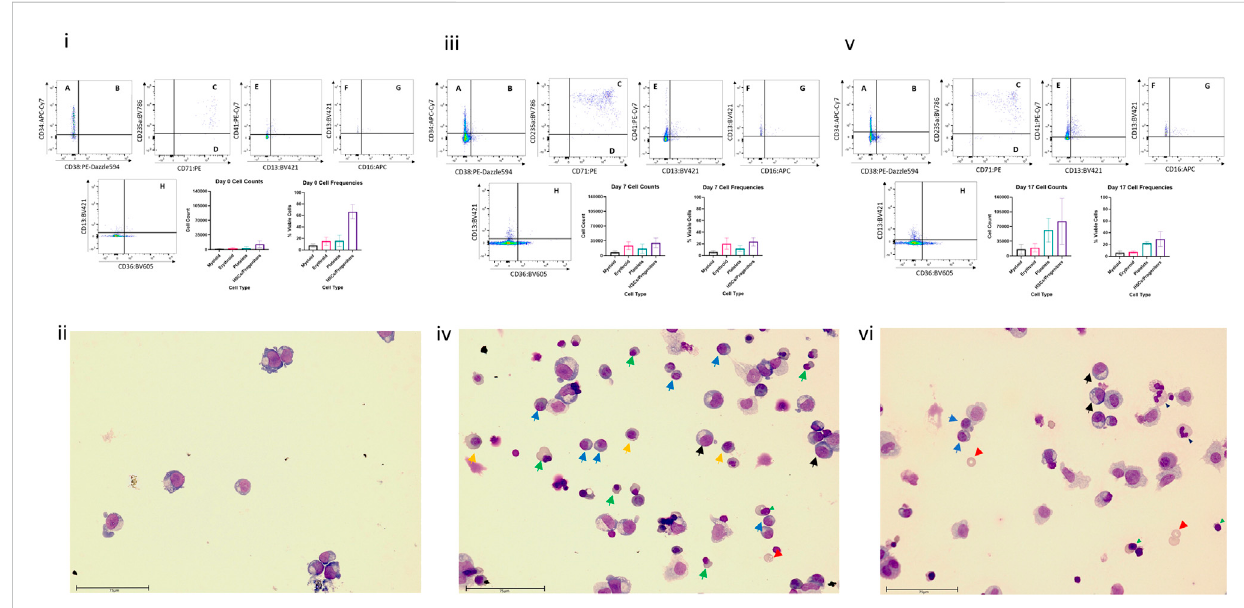
FIGURE 3 CelldifferentiationintheBMMPS.CellspresentintheMPS(studyBM-3)followingincreasingculturetime(day7,iandii;day14days,iiiandiv;day24, vandvi)determinedby fl owcytometry(i,iii,v)andWrightstaining(ii,iv,vi).Flowcytometryplotsshowcellsinmultiplequadrantsexpressingthefollowing CD markers: A CD38 − CD34 + , long term HSCs; B CD38 + CD34 + , Lineage Differentiated Progenitors; C CD13 − CD36 + CD71 + CD235a+, Late Erythroid; D CD13 − CD36 + CD71 + CD235a − , Early Erythroid; E CD13 − CD41a + , platelets; F CD16 − , CD13 + , Early Myeloid; G CD16 + CD13 + , Late Granulocytes; H CD13 − CD36 + ,LateMonocytes.Graphsdemonstratemeanvaluesandstandarddeviationsofeachlineageinvehiclegroupcircuits.Imagesshowmultiple cell types at varying stages of maturation (Green triangle: basophilic normoblasts; red triangle: polychromatic normoblast; orange triangle: orthochromatic normoblast; blue triangle: reticulocyte; black triangle: promyelocyte; light blue triangle: metamyelocyte; purple triangle: band cell; grey triangle: neutrophil). Scale bar 75 µm.